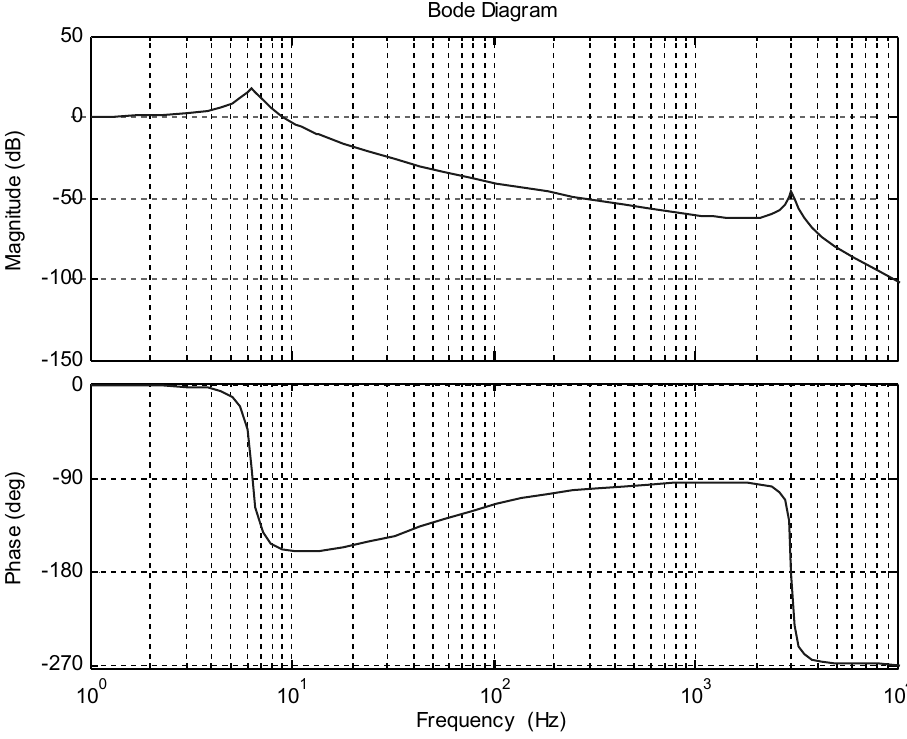
Fig. 8. Bode plot for base exciting acceleration to equipment